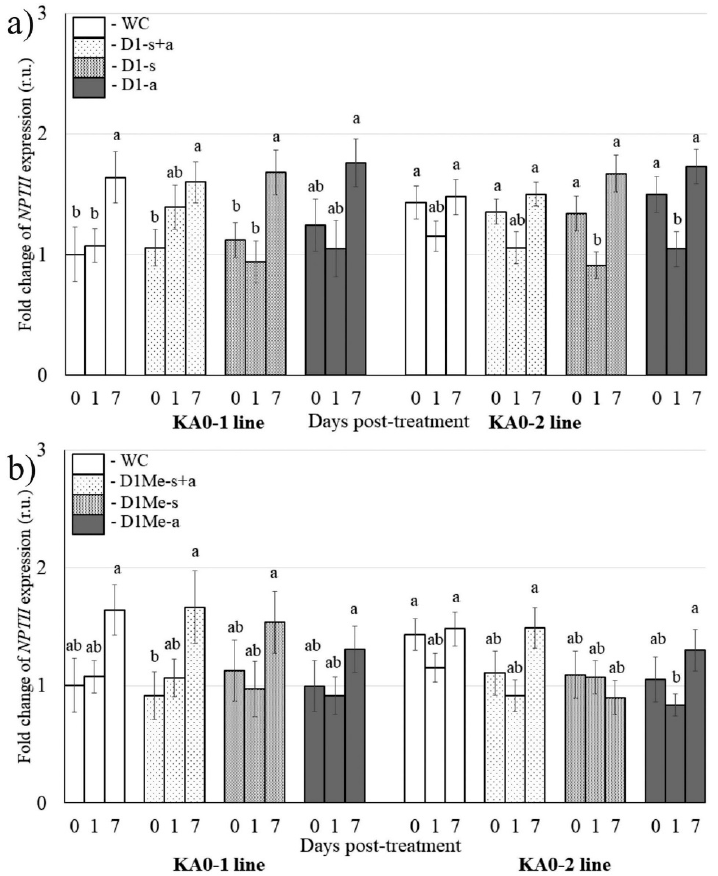
Figure 4. The analysis of NPTII mRNA levels in Arabidopsis thaliana in response to external application of synthetic NPTII -encoding D1 and D1Me DNA oligonucleotides designed to target the 5 ′ end of the transgene. ( a ) Foliar application of unmethylated single-stranded DNA oligonucleotides (D1-s, D1-a) and siRNA-mimicking DNA duplexes (D1-s+a). ( b ) Foliar application of methylated single-